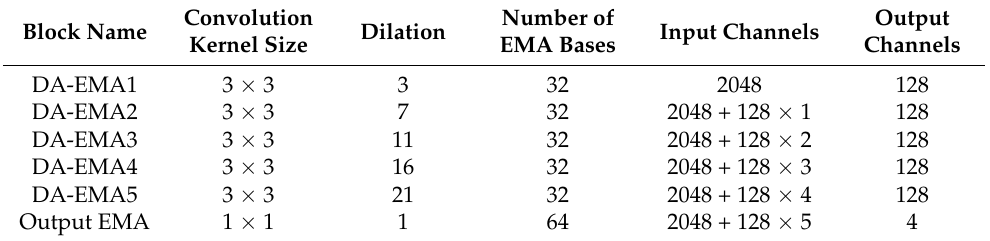
Table 3. Detailed configuration of DA-EMA